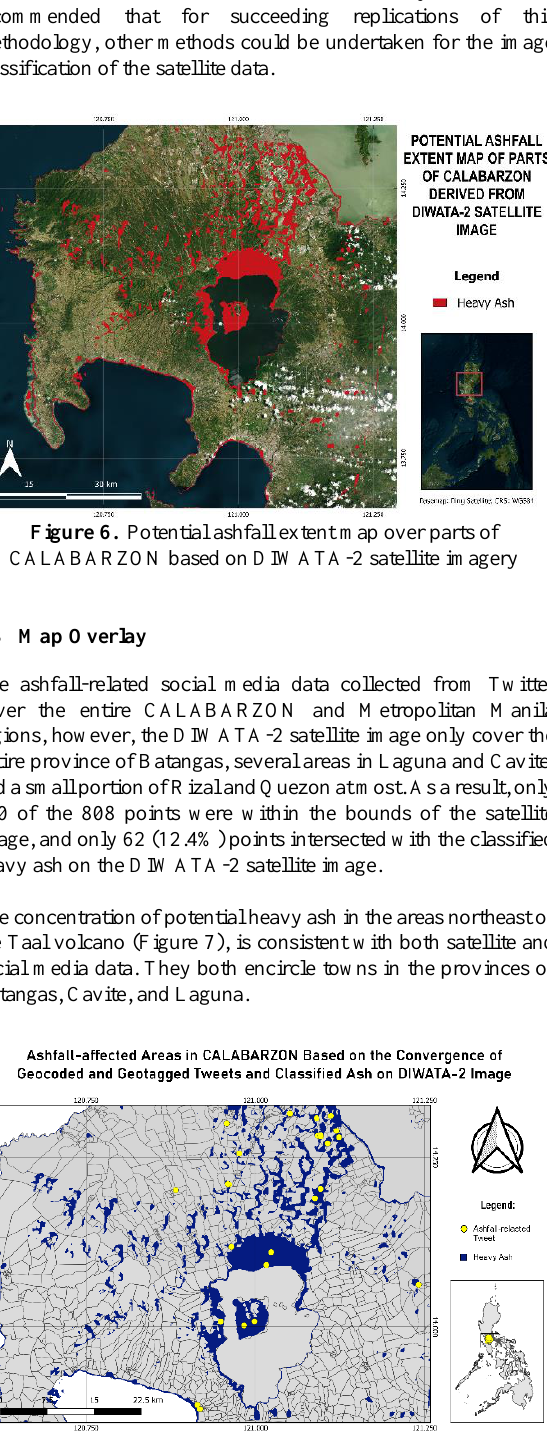
Figure 7. Map overlay of geocoded and geotagged tweets on DIWATA-2 ash extent